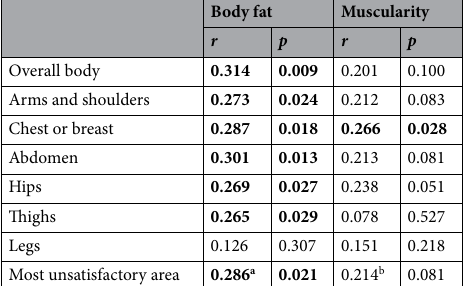
Table 1. Pearson’s correlations (r) between EHQ scores and implicit body fat and muscularity dissatisfaction for various body areas. Significant results are indicated in bold characters. a n = 65. b n =